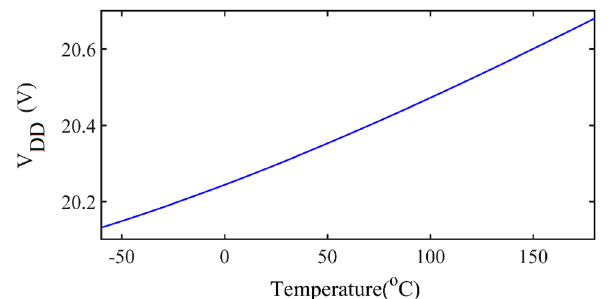
Figure 9. The value of V DD based on temperature.